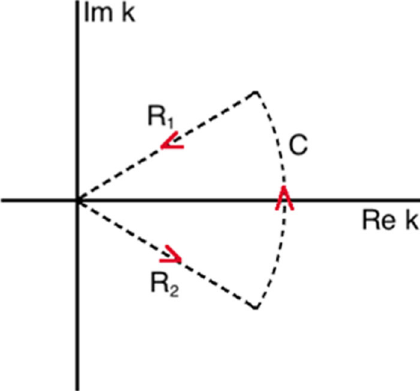
Fig. 1 Complex contour (cid:15) that encloses all the zeroes of f U ( k ) as R → ∞ . In this figure, R 1 : z = ξ e i γ with ξ ∈ [ R , 0 ] ; R 2 : z = ξ e − i γ with ξ ∈ [ 0 , R ] ; C : z = Re i μ with μ ∈ [− γ,γ ] . For the contour (cid:15) , R > 0 and 0 < γ < π/ 2 constants